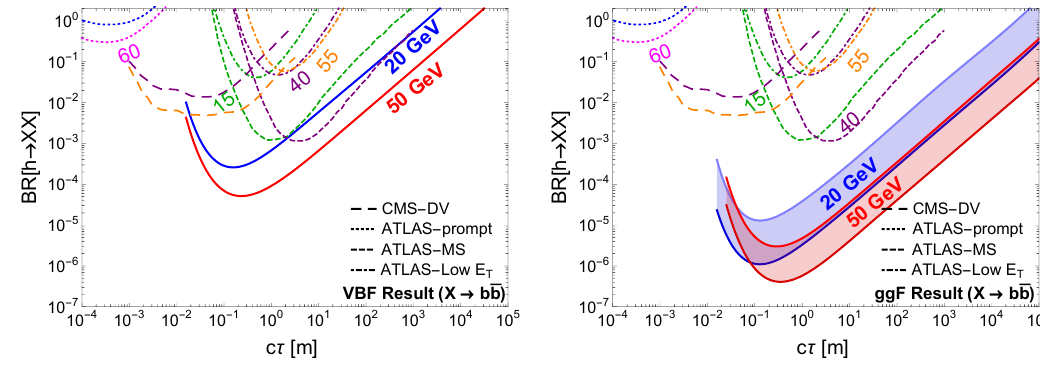
Figure 1 . The projected sensitivity for Higgs decays to long-lived particles with VBF trigger (left panel) and a displaced track trigger for the ggF channel (right panel) at the HL-LHC ( 3 ab − 1 ) as a function of proper lifetime of X using our proposed HGCAL LLP search. We consider two scenarios of the displaced track trigger. The solid line on the top of the shaded region corresponds to the reach with a trigger requirement of H T > 100 GeV, while the solid line on the bottom of the shaded region is obtained without such additional requirement. The existing limits for BR( h → XX ) from ATLAS Run 2 searches based on prompt VH [80] (dotted), the muon spectrometer [18] (dashed), the calorimeter [14] (dot-dashed), with integrated luminosity of 36 fb − 1 , and the CMS search based on displaced vertex in the tracker system [13] (long dashed) with integrated luminosity of 132 fb − 1 , are also shown for comparison. The numbers on different colored lines indicate the mass of the LLP in units of GeV for the corresponding